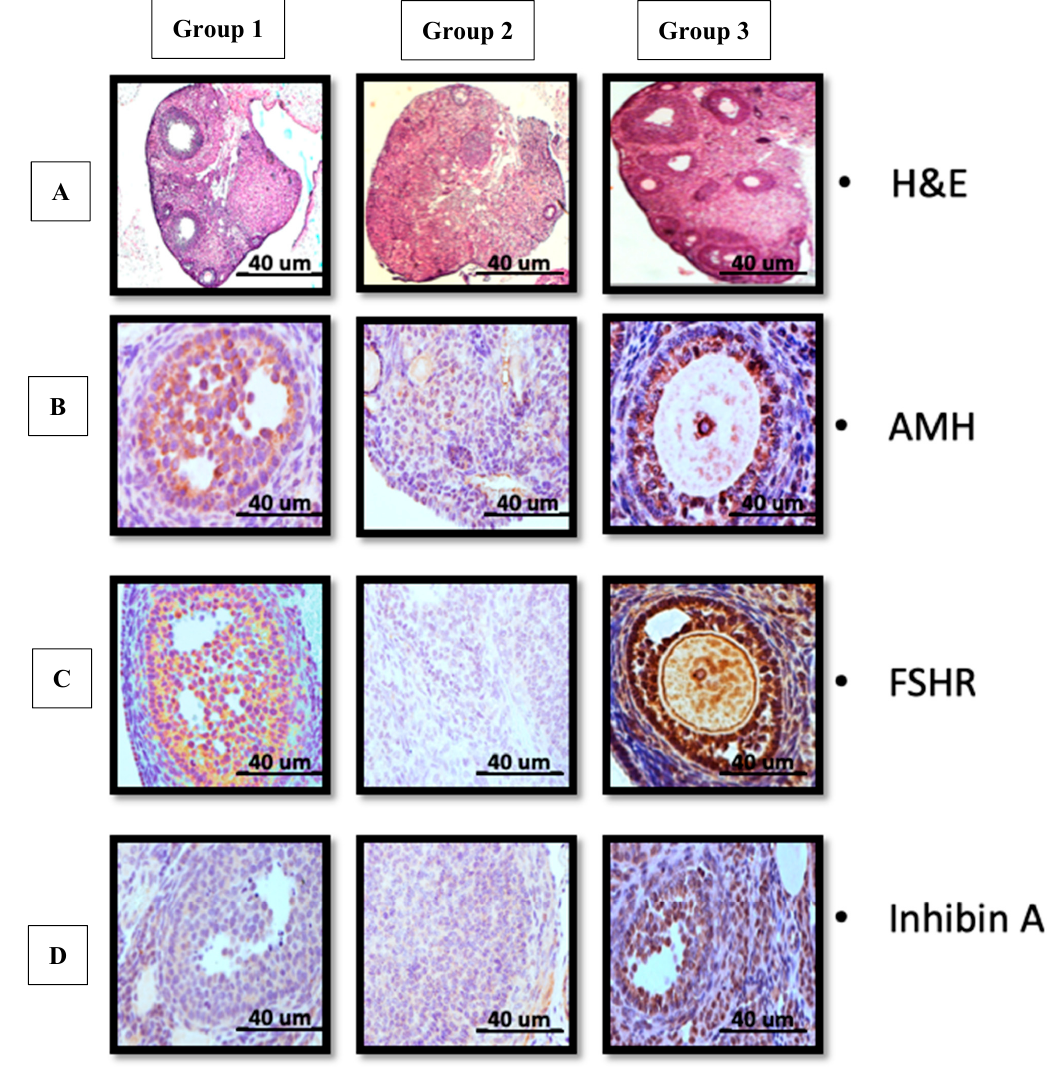
Figure 5. UCMSCs recover ovarian secretory function as shown in ( A ) H&E for group 1 (control) average follicles number and normal tissue distribution, group 2 (CTX) no follicles could be determined and atrophied ovarian tissue, group 3 (UCMSCS) increased number of follicles with revived ovarian tissue. ( B – D ) group 1 and 3 confirmed increased expression of AMH and follicular-stimulating hormone receptor (FSHR) and Inhibin A in contrast to group 2 respectively. (Scale bar 40 µ